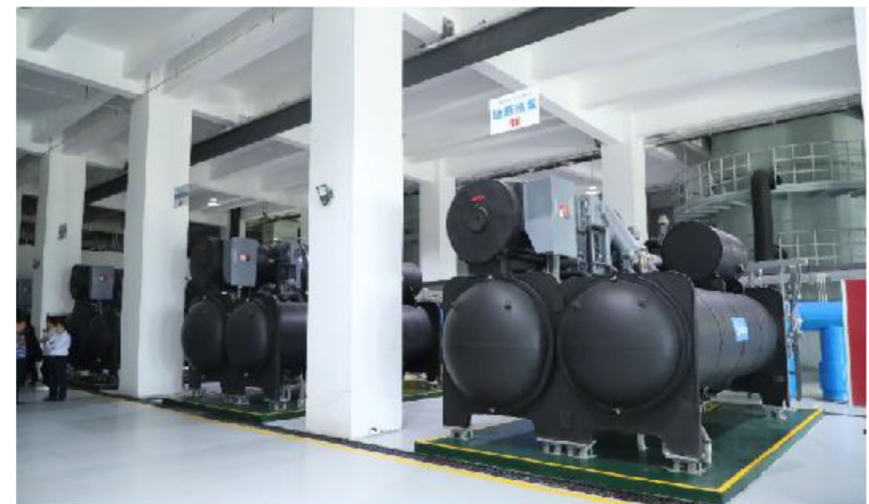
Fig. 14 Full falling film variable frequency centrifugal heat pump